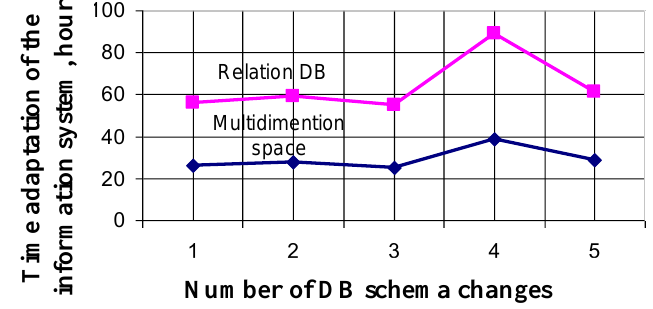
Fig. 6. Comparing adaptation time of the information system with a relational database and a multidimensional